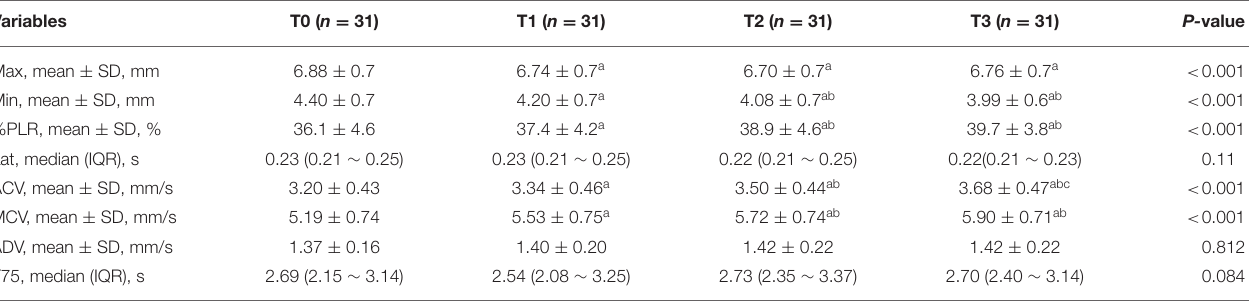
TABLE 1 | The results of PLR for both eyes through the whole process of driving